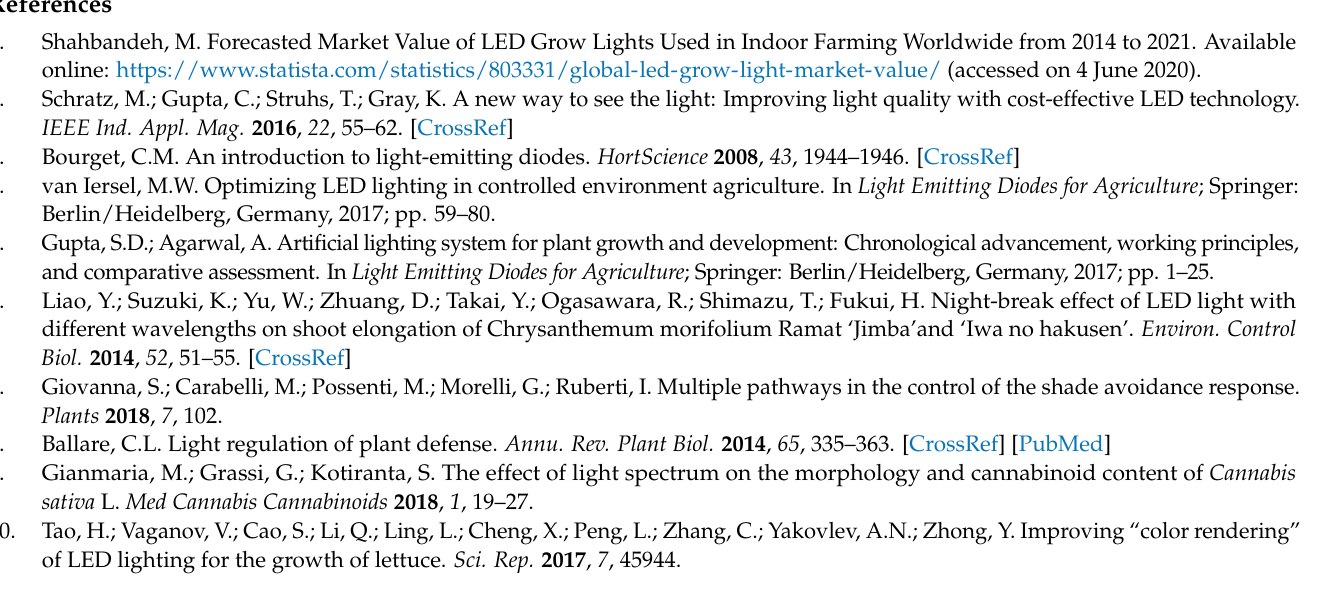
unit (plant) in the growth chamber for the perpendicular light gradient